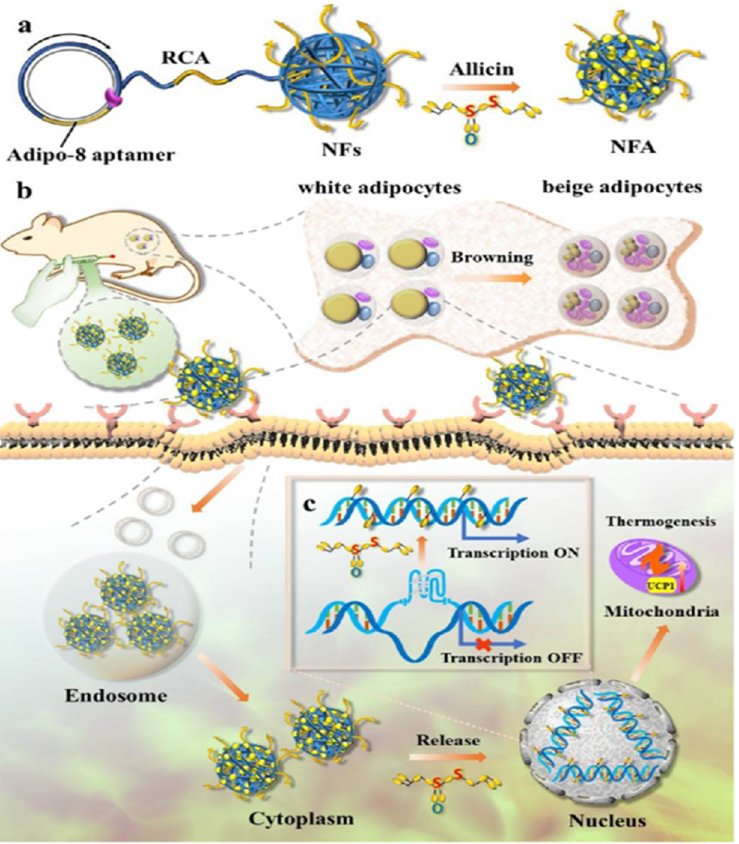
Figure 3. Schematic illustration of effective obesity restraint through targeted activation of G4-mediated UCP1 expression. ( a ) Schematic illustration of the synthesis process of aptamer-functionalized binary-drug delivery system. ( b ) The NFA binds to the target receptor (adipocyte plasma membrane-associated protein) in the cellular membrane. ( c ) Allicin decreases the stability of G454 in the UCP1 promoter, increasing UCP1 expression in adipose cells. Upon entering the cytosol, intracellular target (G454) recognition events trigger the expression of UCP1 of adipose cells, increasing systematic energy expenditure. Reproduced with permission [126]. Copyright 2022, American Chemical